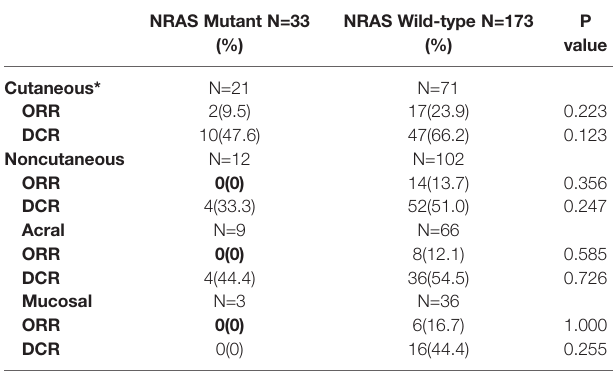
TABLE 2 | Ef fi cacy of immunotherapy in NRAS mutant and NRAS wild-type melanoma. NRAS Mutant N=33 NRAS Wild-type N=173 (%) (%)